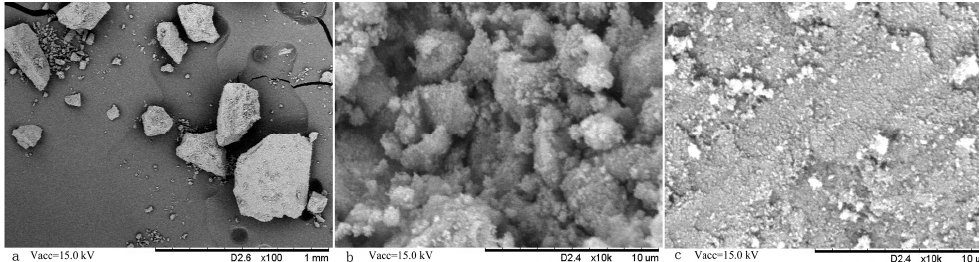
Figure 2. Scanning electron micrographs of the MMIPs and MNIPs: ( a ) MMIPs; ( b ) surface of MMIPs; ( c ) surface of MNIPs.